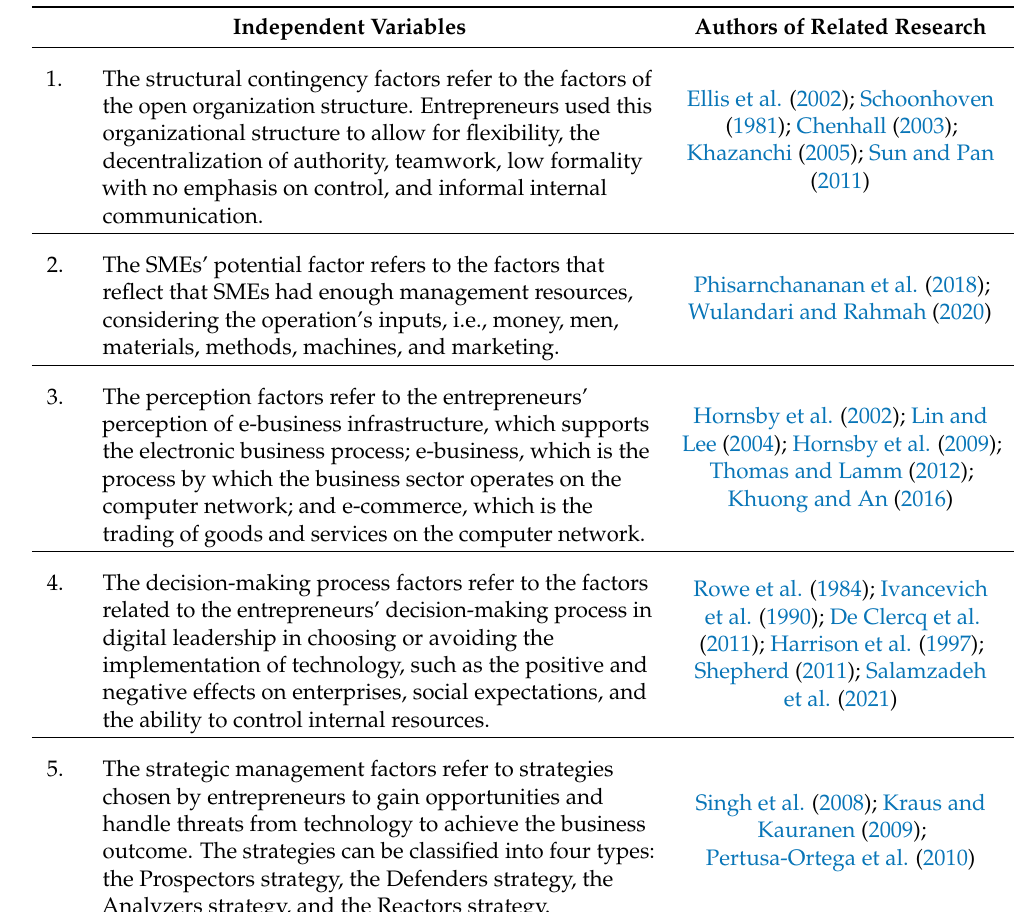
Table 1. Independent variables in the